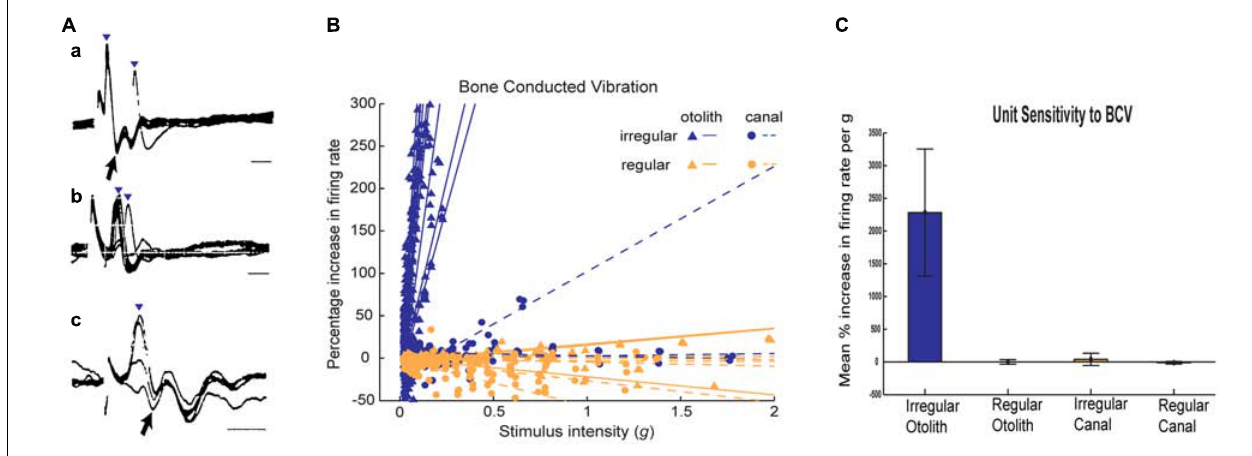
FIGURE 5 | (A) Irregular otolithic primary afferents are evoked by air conducted clicks at very short latencies (from Murofushi et al., 1995). Three examples of air conducted click-evoked action potentials (identified by inverted triangles) in three primary otolithic neurons. Superimposed recordings of responses to 5–10 clicks. Latencies from the onset of the click to the foot of the action potential were 0.5 ms (a,c) and 1.0 ms (b). b and c show responses at threshold-straddling intensities, so the action potential is not evoked on every presentation. Note that these action potentials (a, c) occur at such short latencies they precede the N1 wave of the acoustically evoked cochlear action potential (arrows). Time scales 1 ms. Reproduced from Murofushi et al. (1995) with Permission of Springer (B) Examples of sensitivity plots of neurons to BCV showing the high sensitivity of irregular neurons to increasing BCV stimulus strength as opposed to regular afferents. Each point shows the increase in firing rate as the percentage of baseline firing rate during a single stimulus presentation. Each line is the best fit calculation of the responses for one neuron (triangles - otolith neurons, circles-semicircular canal neurons; irregular afferents are blue and regular afferents are orange. The stimulus intensity is calculated in g , and is the root mean square of three axes as recorded by the skull-mounted triaxial accelerometer. Canal neurons and regular otolithic afferents are not activated by high stimulus levels. In contrast irregular otolithic afferents are activated at very low intensities and have a very steep increase in firing as intensity is increased. (C) Average sensitivities for neurons to BCV. The slopes of the best fitting lines in (B) are averaged for each class of neuron, and the average slope and 95% confidence intervals. The unit of sensitivity in this plot is per cent increase in firing rate per g above the resting discharge rate. The high sensitivity of otolith irregular neurons and the absence of response of otolith regular and semicircular canal neurons is clear. Reproduced from Curthoys and Vulovic (2011) with permission of